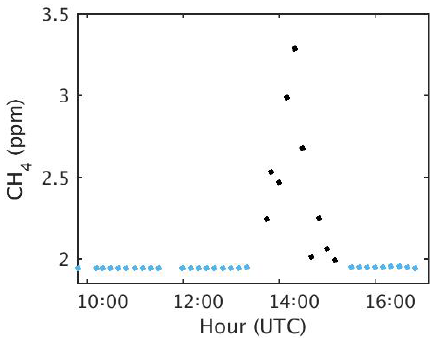
Figure 16. Time series of CH 4 encompassing one of the eight peaks in CH 4 at the central tower (DOY 55) for which the Keeling plot ap- proach was applied. The averaging interval of the individual points was 10min, and periods during which field tanks were sampled were excluded from the plot. The linear fit was calculated using the points clearly within the plume (black